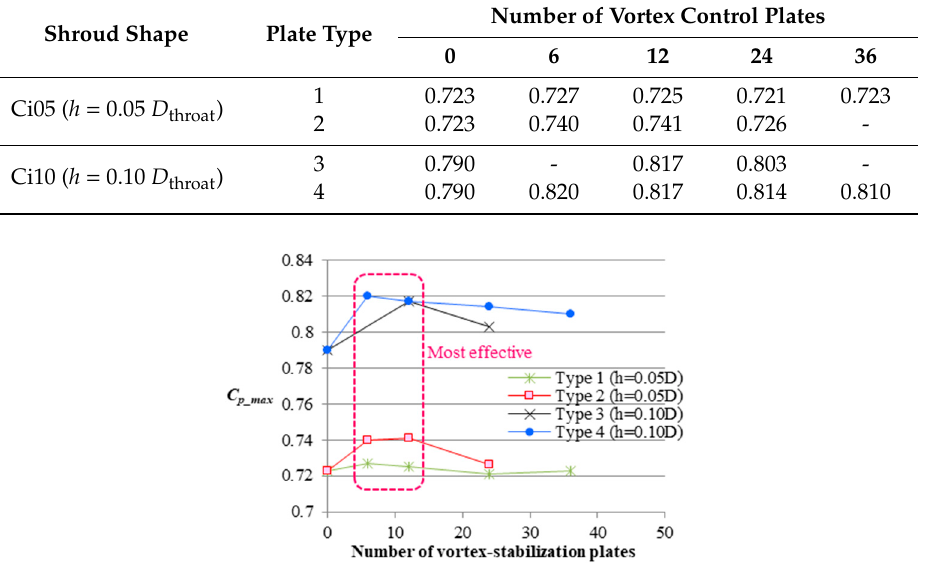
( b ) Figure 13. Nondimensionalized wind speeds in the streamwise direction near the inside wall of the WLT Ci10 duct (without the turbine): ( a ) Inflow wind speed U 0 = 4 m/s; ( b ) Inflow wind speed U 0 = 8 m/s.